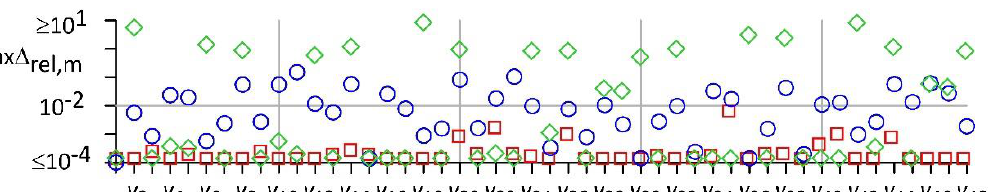
Figure 14. The smallest of the obtained values max Δ rel,m for poly = 1, α max *( x ) = 0.30, different degrees of the base reference POb and the groups of functions used to generate discrete data: ( a ) considering all the approximations, ( b ) considering only the polynomial approximation.